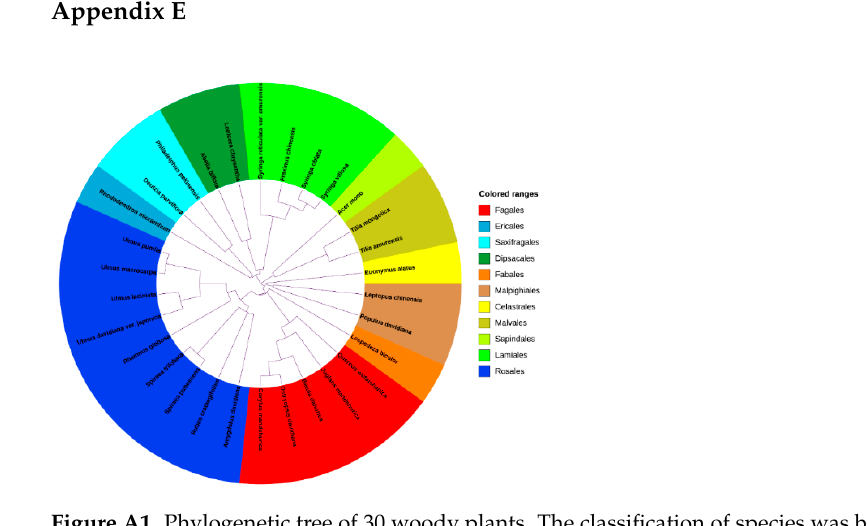
Figure A1. Phylogenetic tree of 30 woody plants. The classification of species was based on the APG IV system; different colors represent different